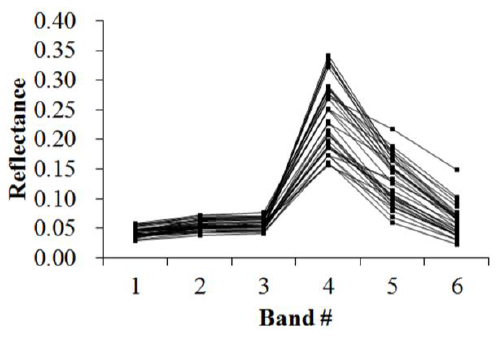
Figure 7. Spectral curves collected from samples used to determine Table 5. ISPRS Int. J. Geo-Inf. 2016 , 5 , 154 Table 5. Identification template 1 for forest class.